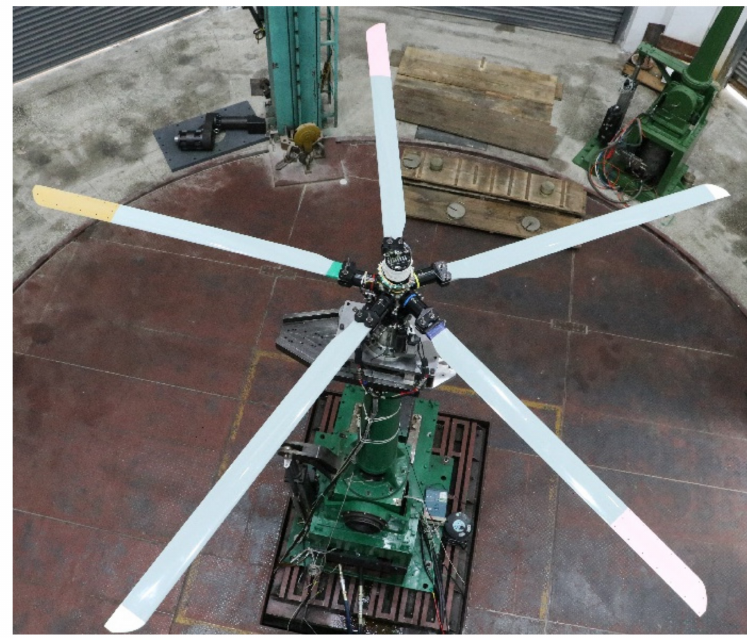
Figure 1. Test stand and rotor model.